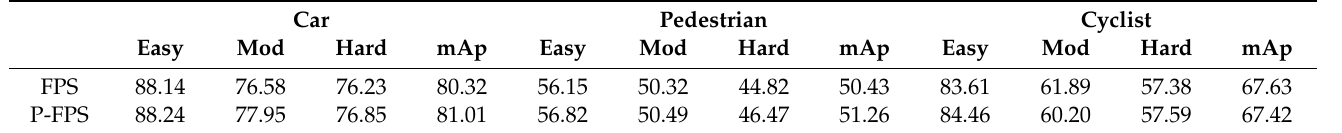
Figure 11. Performance comparisons on different α. Table 5. Results of 3D detection on the rain noise data with different sample methods.